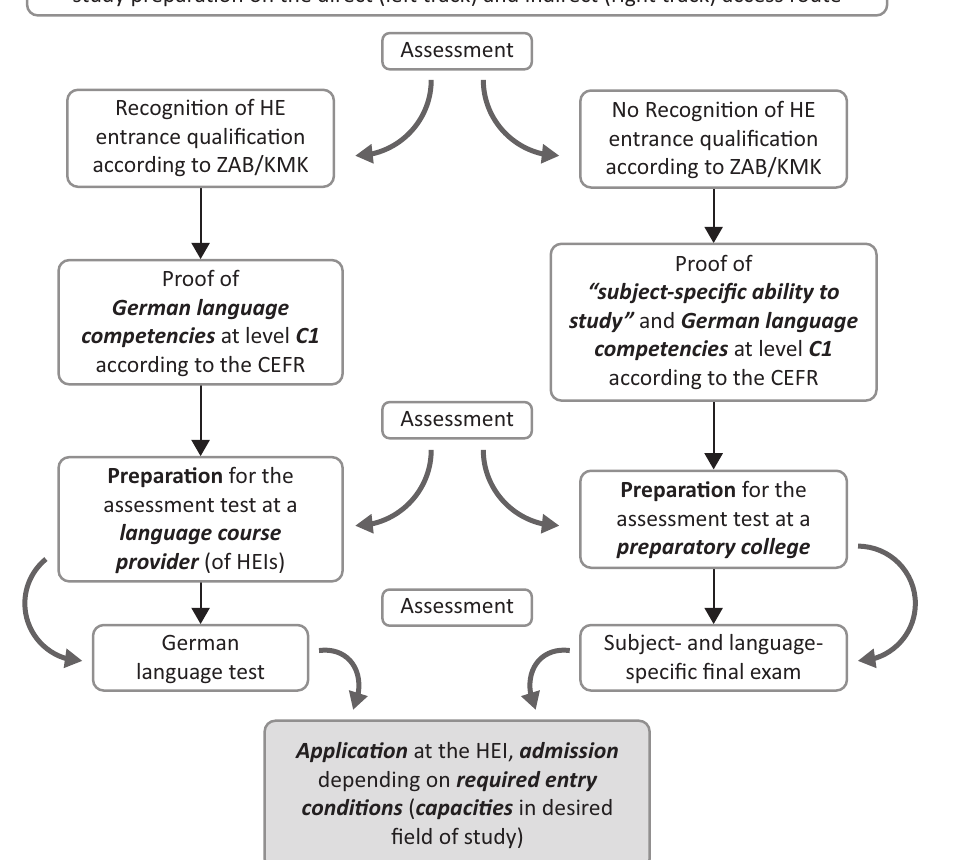
Figure 1. Evaluation process of non‐EU international students’ HE entrance certificates and obligatory study preparation on the direct and indirect access route. Notes: ZAB stands for Central Office for Foreign Education; KMK is that Standing Conference of the Ministers of Education and Cultural Affairs; CEFR stands for Common European Framework of Reference for Languages. Source: Own graphic following Lower Saxony Ministry of Science and Culture